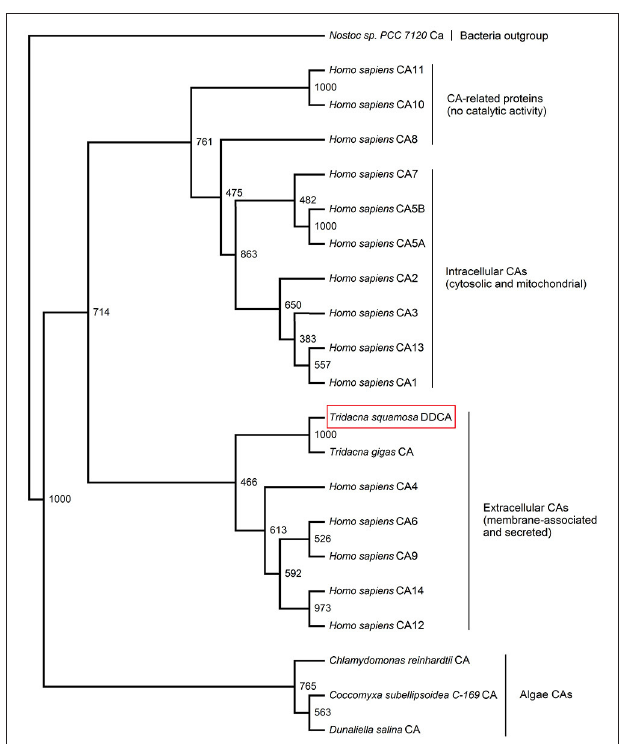
FIGURE 2 | A phenogramic analysis of the Dual Domain Carbonic Anhydrase (DDCA) of Tridacna squamosa. A phenogram illustrating the relationship of the DDCA of T. squamosa with all known CAs of Homo sapiens , Tridacna gigas CA (tgCA) and CAs of several species of algae. The Ca of the bacterium Nostoc sp. ( PCC7120 ) was used as the outgroup. The number located at each branch point represents the bootstrap value (max =